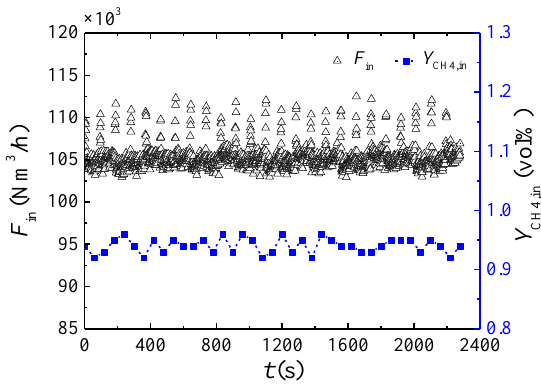
Energies 2018 , 11 , x FOR PEER REVIEW 6 of 13 change pattern occurs in the five beds. However, the temperature profiles of the beds are different from one another. Therefore, the cycle steady state (CSS) is asymmetrical. The main cause of this phenomenon is that part of the hot gas is extracted from the combustion chamber, which affects the Figure 3. Monitoring data for the flow rate ( F in ) and methane concentration ( Y CH4,in ) at the inlet during Figure 3. Monitoring data for the flow rate ( F in ) and methane concentration ( Y CH4,in ) at the inlet during flow field and temperature distribution in the reactor. five cycles when F in = 105 × 10 3 Nm 3 /h, Y CH4,in = 0.94 vol %, and t c = 450 s. five cycles when F in = 105 × 10 3 Nm 3 /h, Y CH4,in = 0.94 vol %, and t c = 450 s.